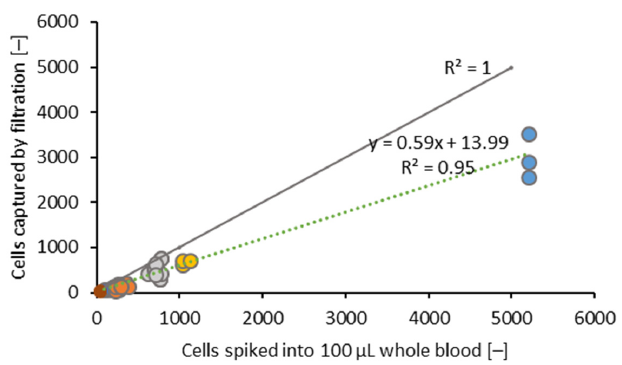
Figure 7. Linearity of the cell capture for 7.4 µm TEM-grids. Two hundred microliters of healthy whole blood were spiked with 50, 100, 300, 600, 1000, or 6000 cells. Filtrations for each cell number were performed at least in triplicates. The cells for spiking were stained and counted in 96-well microtiter plates by fluorescence microscopy beforehand. The grey line shows the spike-and-capture for a theoretical capture rate of 100%. The dotted line represents the linear fit of the spike-and-capture linearity of the HCT116 cells on the TEM-grid.